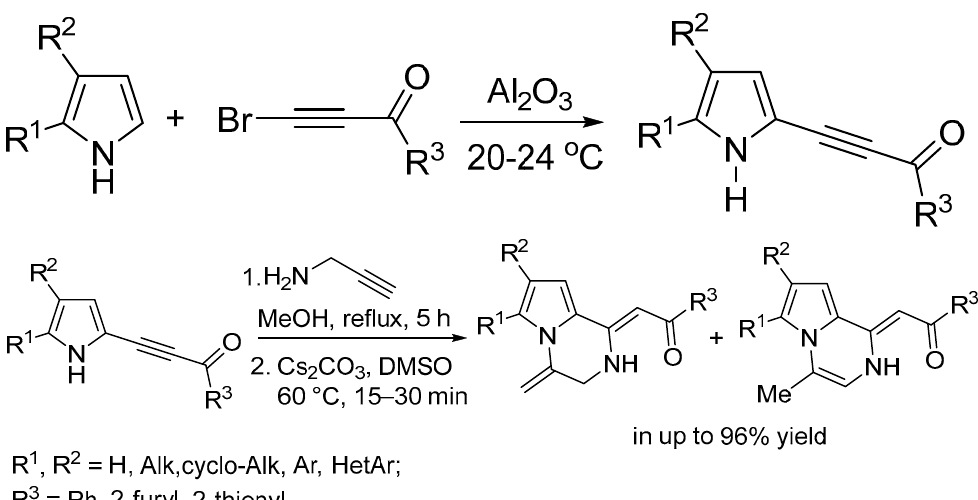
of methods for the synthesis of dipyr-